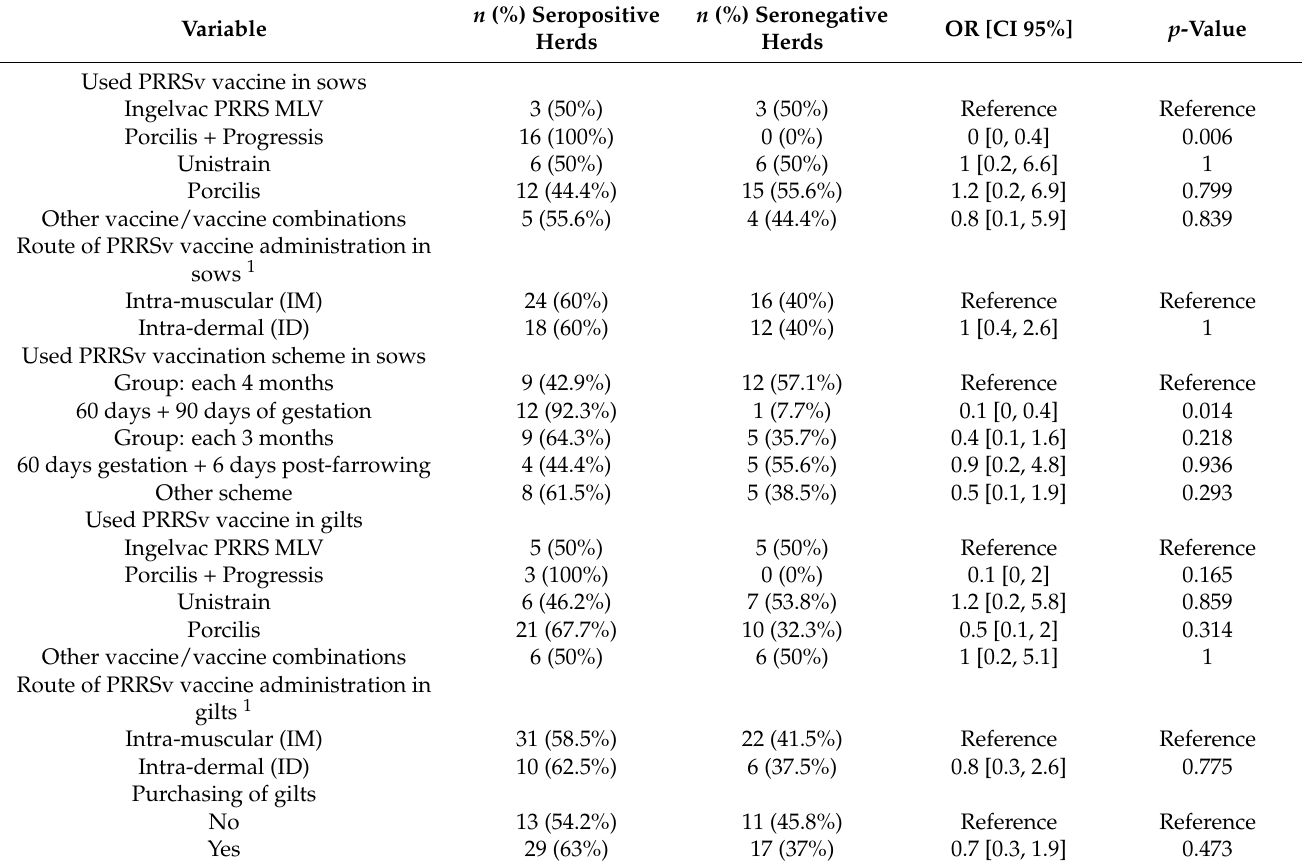
Table 5. Univariable logistic regression of the categorical herd variables ~ presence of at least one ELISA 1 (IDEXX PRRS X3) seronegative sow (“seronegative herd”). Results are shown as the number ( n ) of seropositive and seronegative herds for each variable, with the percentage of seropositive and seronegative herds for each variable between brackets. The odds ratio (OR) and 95% confidence interval (CI 95%) of the OR express the risk for being a seronegative herd when having a certain herd variable, compared to the reference variable. OR with a p-value < 0.05 is considered significant. n (%) Seropositive n (%) Seronegative OR [CI 95%] p Variable Herds Herds